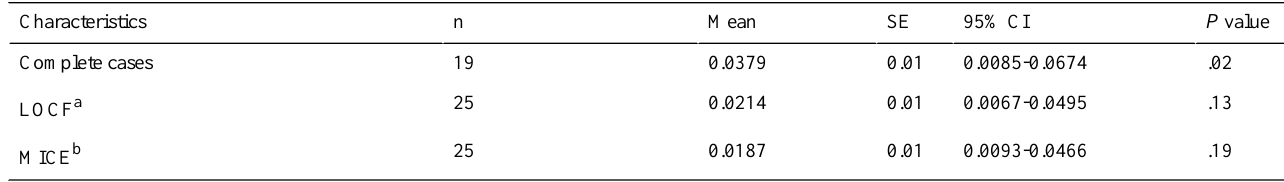
Table 5. Paired t test results on change of quality-adjusted life years at 12 months after baseline.